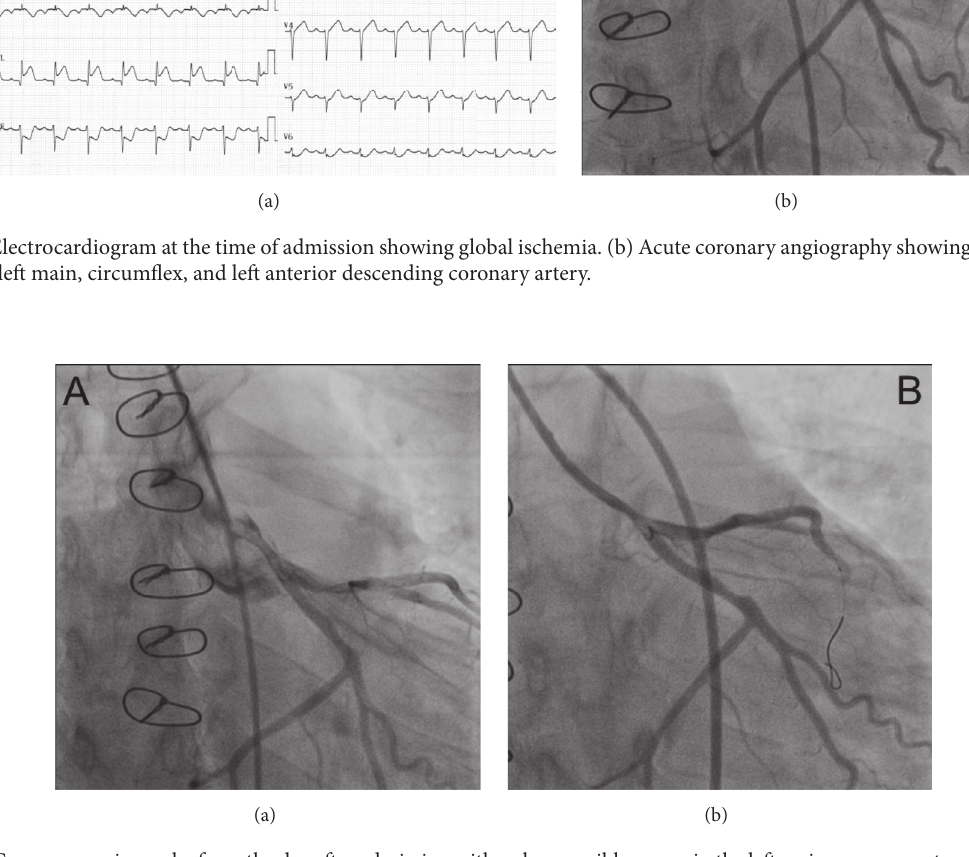
Figure 2: (a) Coronary angiography from the day after admission with only a possible spasm in the left main coronary artery (LMCA) and no spasms in the left anterior descending or circumflex (CX) coronary artery. (b) Third coronary angiography performed 6 days after admission showing LMCA and ostial CX